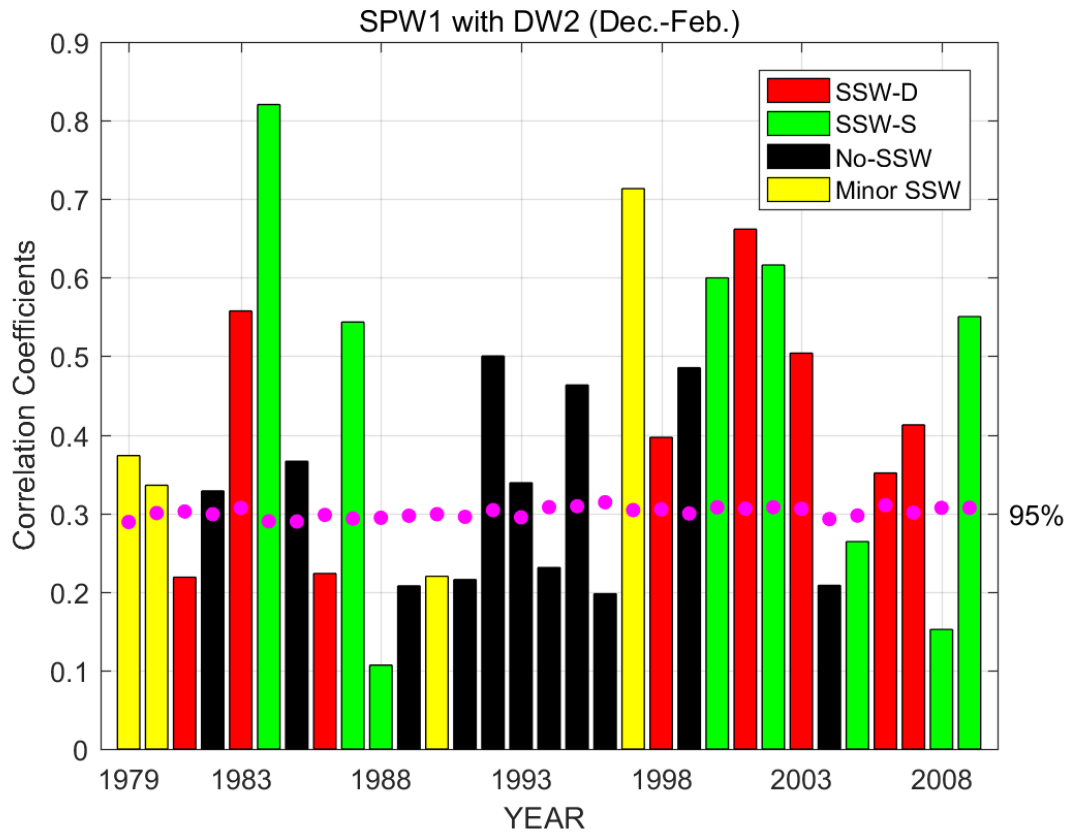
Figure 5. Highest correlations between SPW1 and DW2 for 31-winters from 1979 to 2010 under different SSW (sudden stratospheric warming) scenarios.